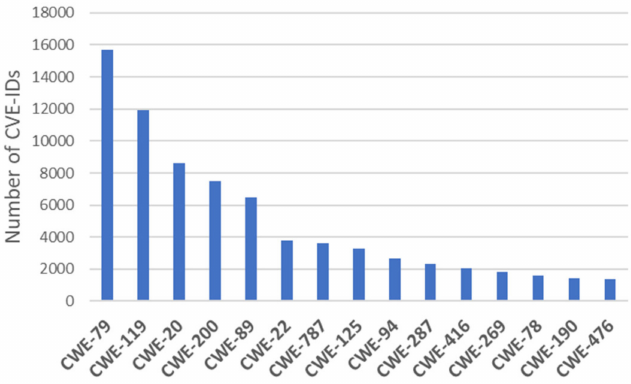
Figure 8. Vulnerability distribution by